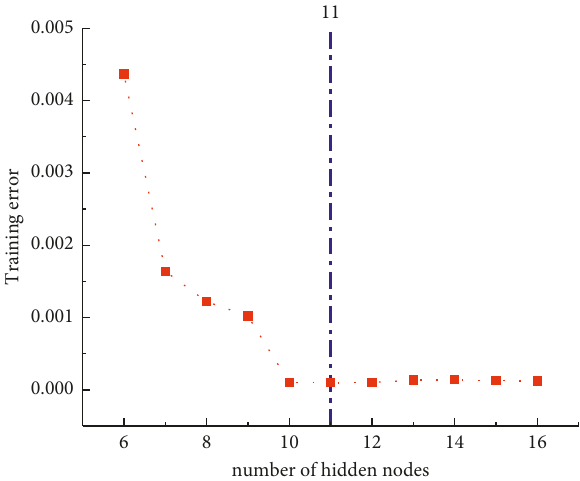
Figure 10: Correlation mathematical fitting curve between the number of nodes and the experimental normalization error nodes. Figure 13 is an overall model data display effect diagram.